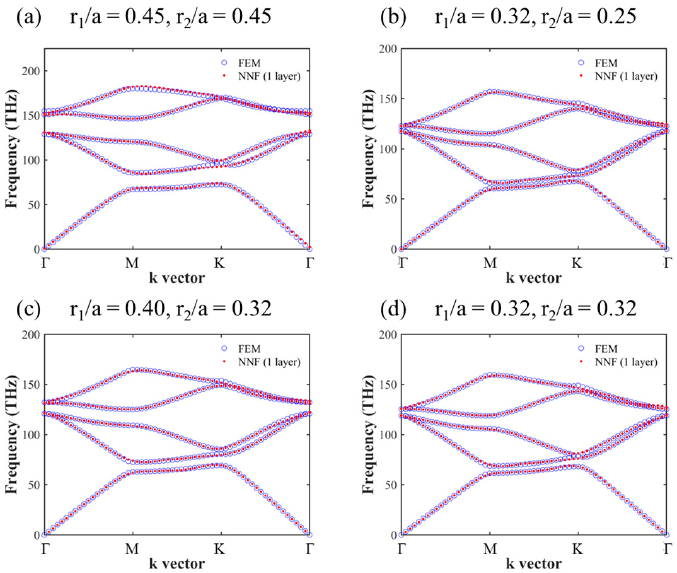
Figure 7. FEM-calculated (blue circles) and predicted (red dots) band structures of honeycomb lattice photonic crystals with ( a ) r 1 /a = 0.45, r 2 /a = 0.45, ( b ) r 1 /a = 0.32, r 2 /a = 0.25, ( c ) r 1 /a = 0.4, r 2 /a = 0.32, and ( d ) r 1 /a = 0.32, r 2 /a = 0.32.